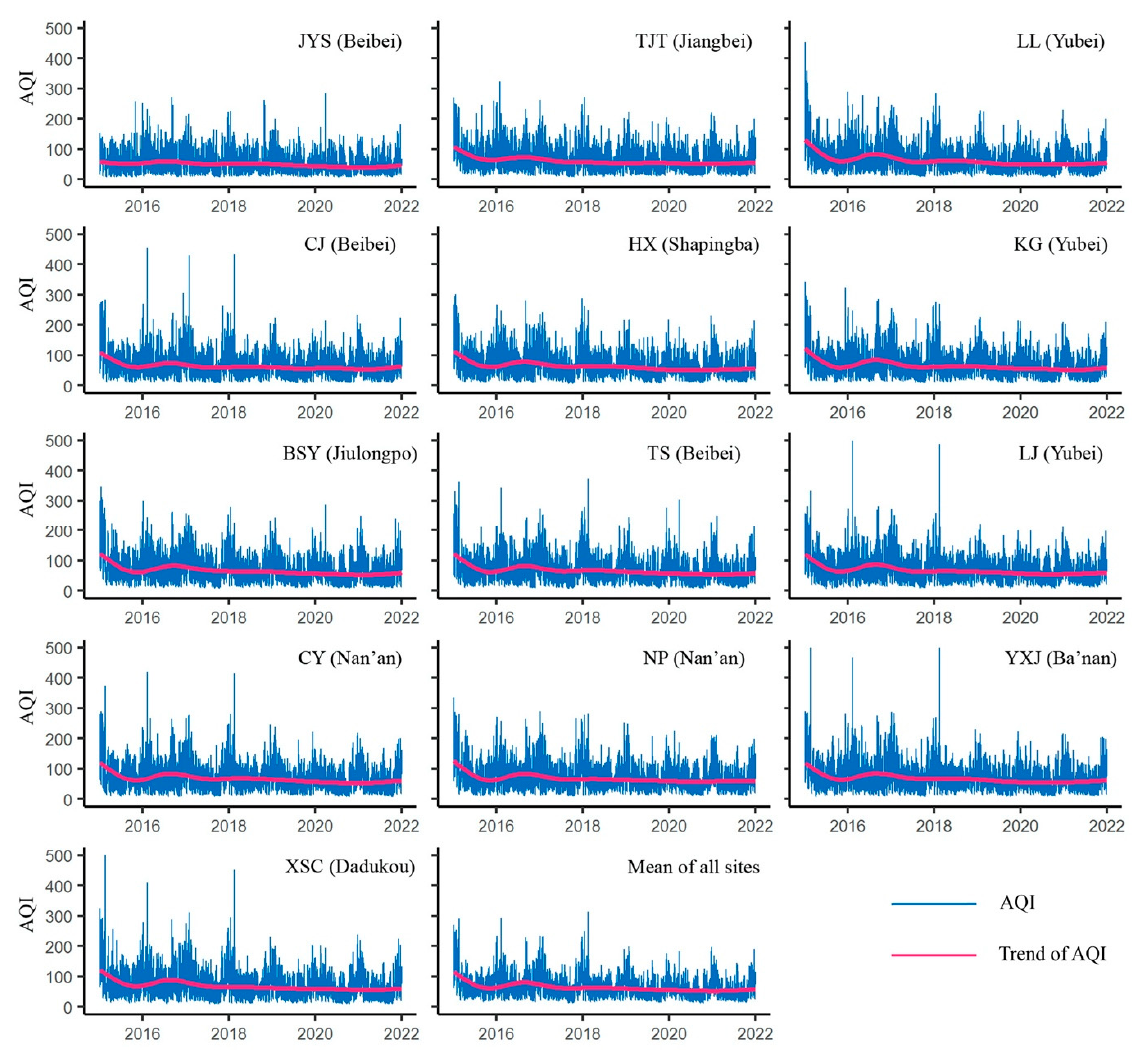
Figure 3. Time series changes of hourly AQI for each site and mean of all sites between 2015 and 2021.